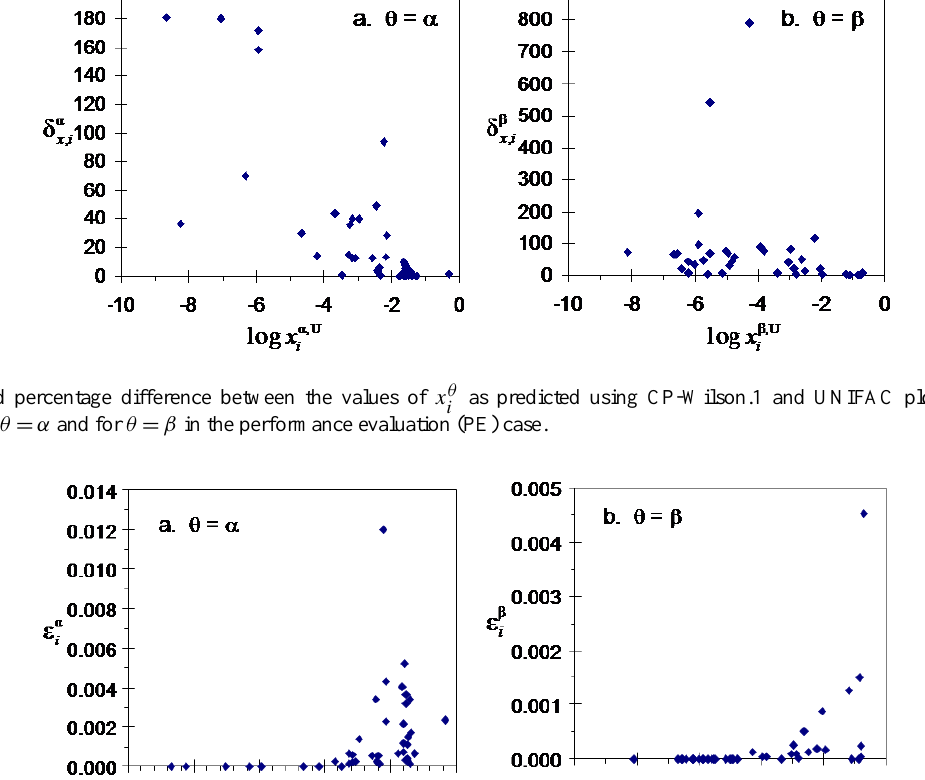
as predicted using CP-Wilson.1 and UNIFAC expressed as a percentage of ( M TPM ) U i